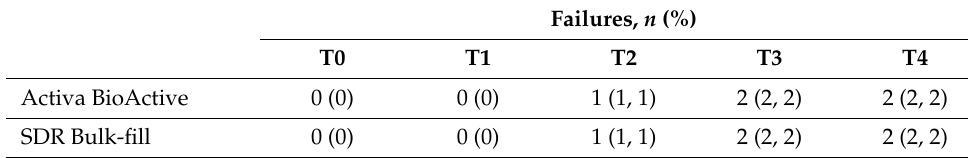
Table 3. Restoration failures.